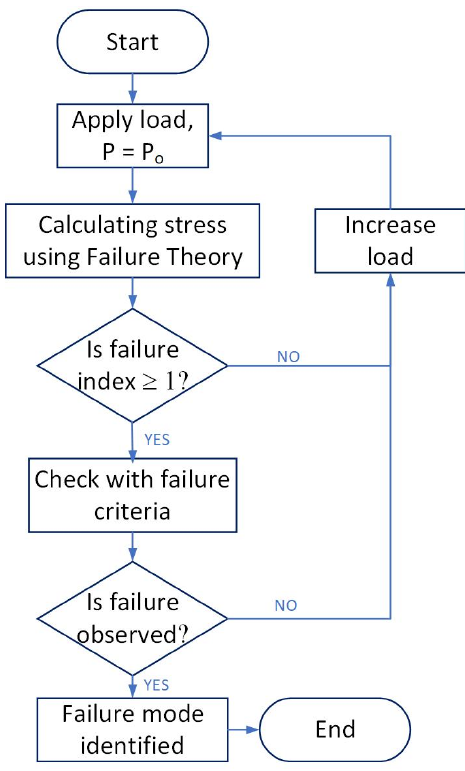
Figure 7. Flowchart of failure criterion.